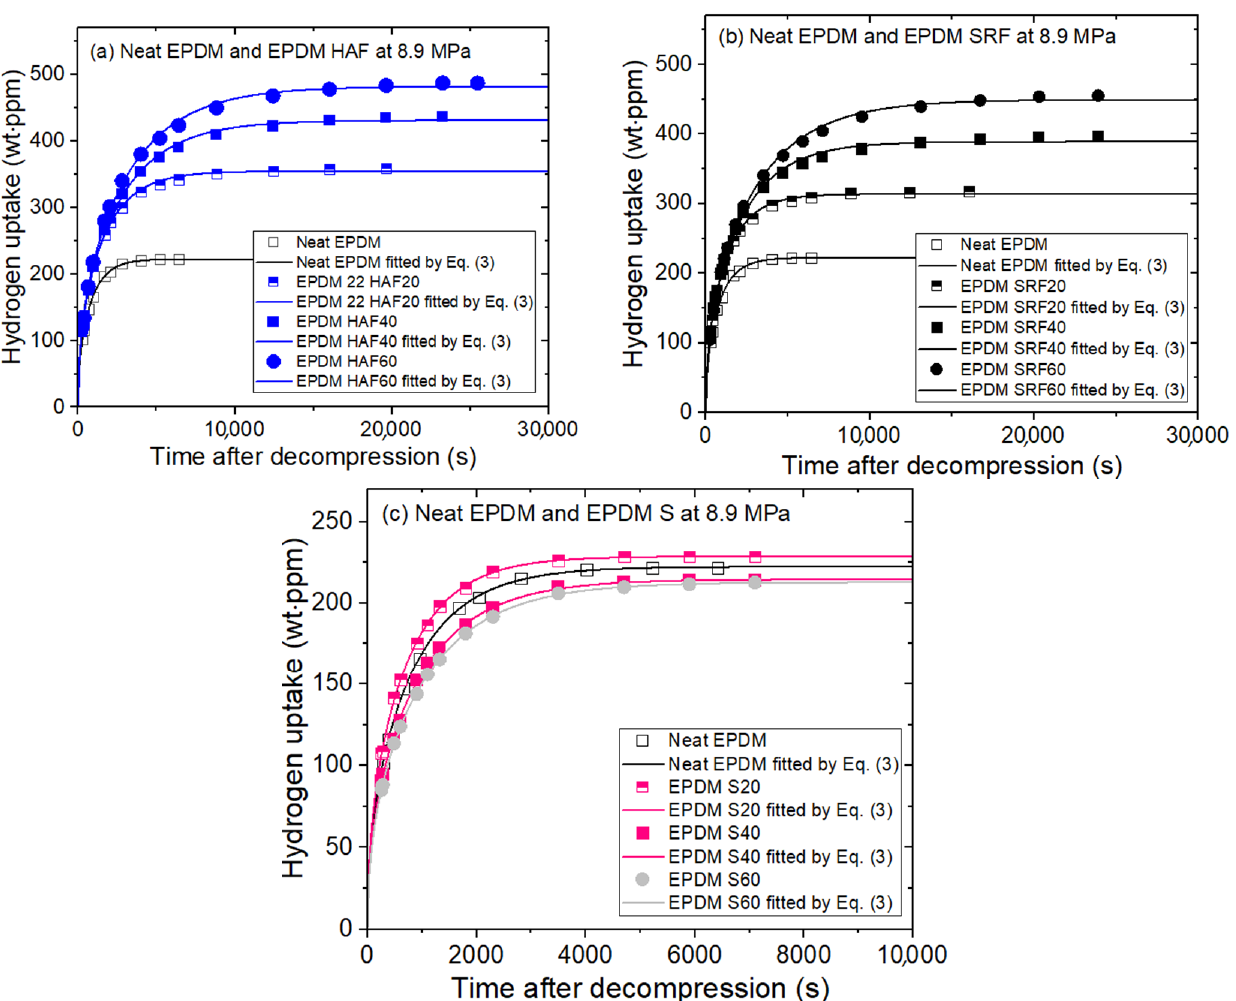
Figure 4. H 2 uptake characteristics of the ( a ) EPDM HAF, ( b ) EPDM SRF, and ( c ) EPDM S series after hydrogen exposure at 8.9 MPa for 20 h and decompression. The solid lines are the least-squares fittings of Equation (3) using the diffusion analysis program. The results of neat EPDM are included in three panels for comparison with the EPDM composites blended with